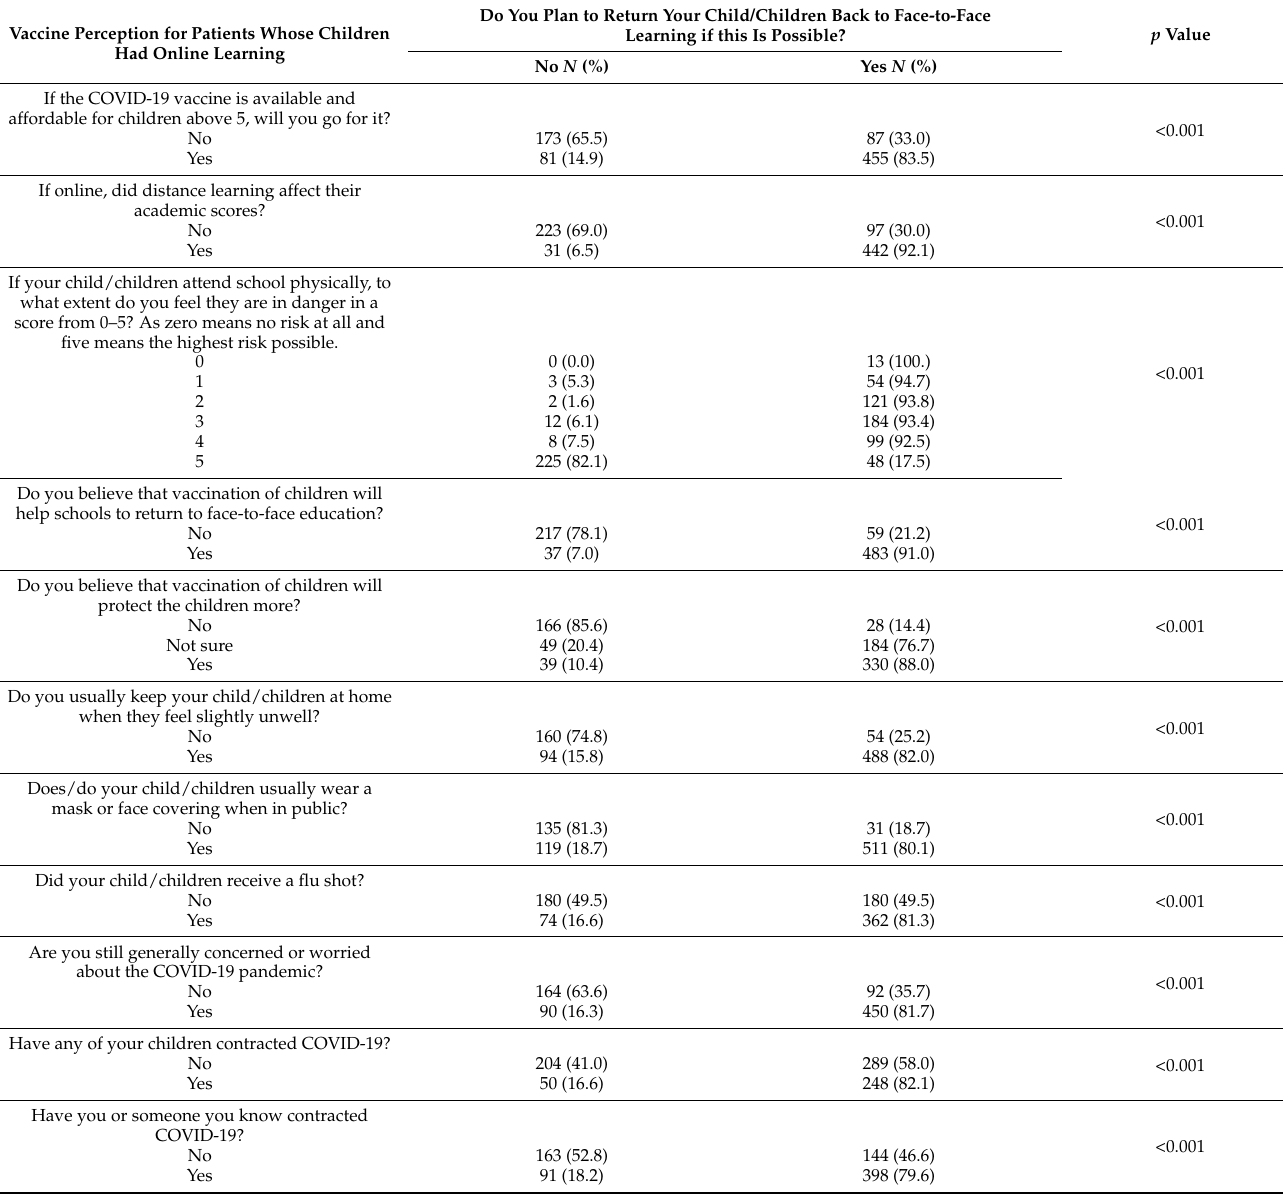
Table 6. Association between parents’ perspectives towards COVID-19 vaccine and parents’ willing- ness to get their children back to school ( n =